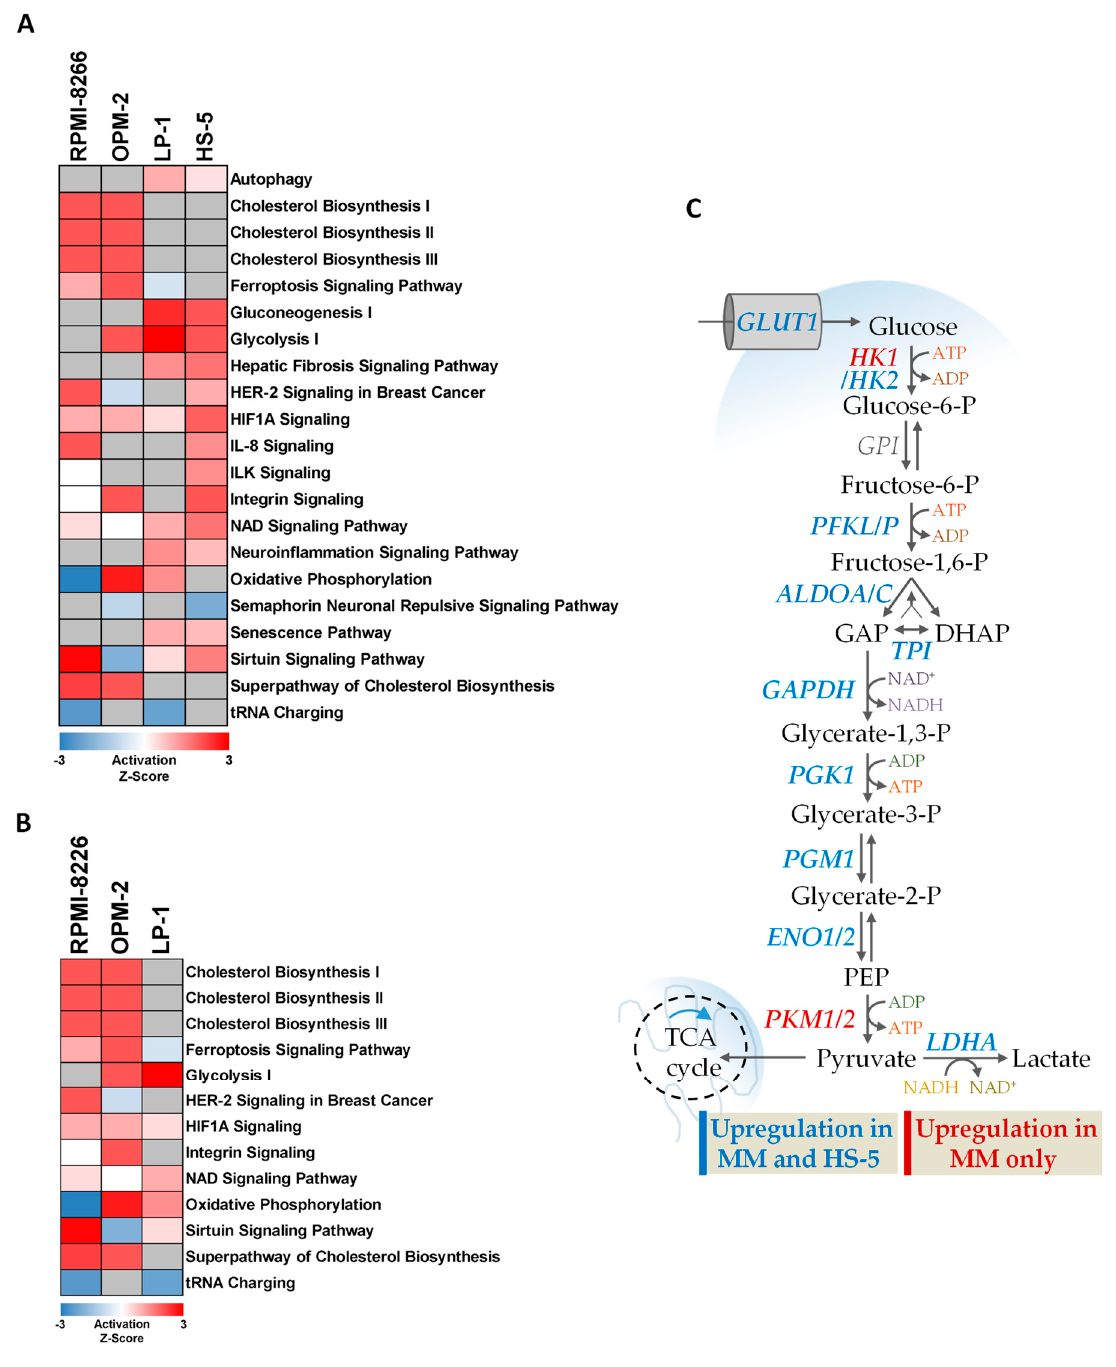
Figure 4. Pathway analysis of hypoxia-regulated pathways in MM and HS-5 cells: Proteins considered to be regulated in each cell line were subjected to Ingenuity core analysis and activation Z-scores of pathways scoring in at least 2 cell lines were plotted. MM cell lines RPMI-8226, LP-1 and OPM-2 and with ( A ) and without ( B ) the bone marrow stromal cell line HS-5 cells. ( C ) Illustration of the individual glycolytic enzymes identified in our LC/MS measurement. Upregulation was defined as normalized log2 SILAC ratio chronic hypoxia/normoxia >0.6. Upregulation in MM cells was defined as upregulation in at least one MM cell line. Abbreviations: P = phosphate, GAP = glyceraldehyde-3-phosphate, DHAP = dihydroxyacetone-phosphate, PEP = phosphoenolpyruvate. For an additional validation of the results of the LC-MS/MS measurement, protein expression of HK2 and LDHA were assessed in RPMI-8226, LP-1 and OPM-2 cells and an additional MM cell line U266, as well as in the bone marrow stromal cell line HS-5 in